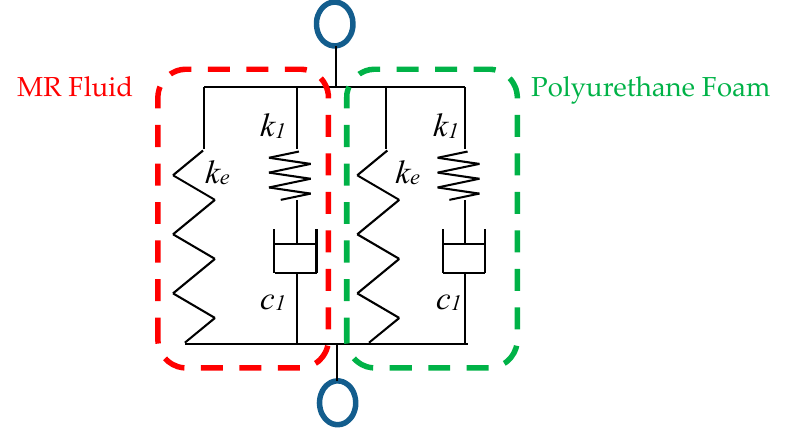
Figure 6. Mechanical model of MR sponge device.